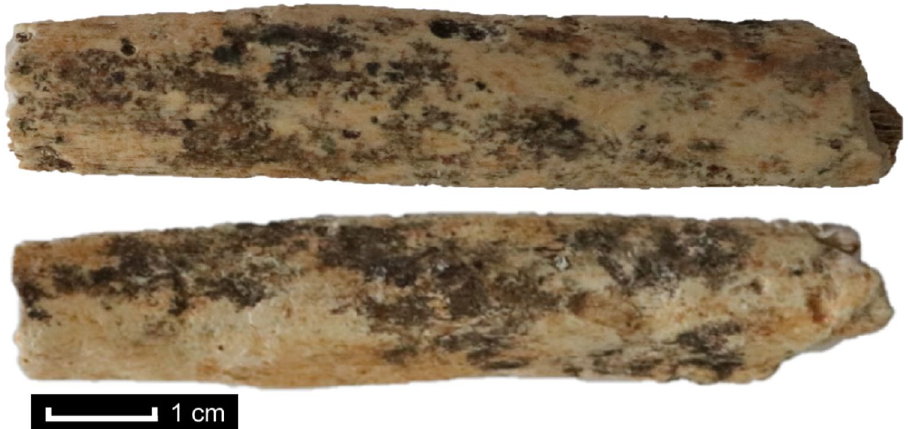
Fig. 1 Front (upper photo- graph) and back surface (lower photograph) views of a bear rib (shaft) bone excavated